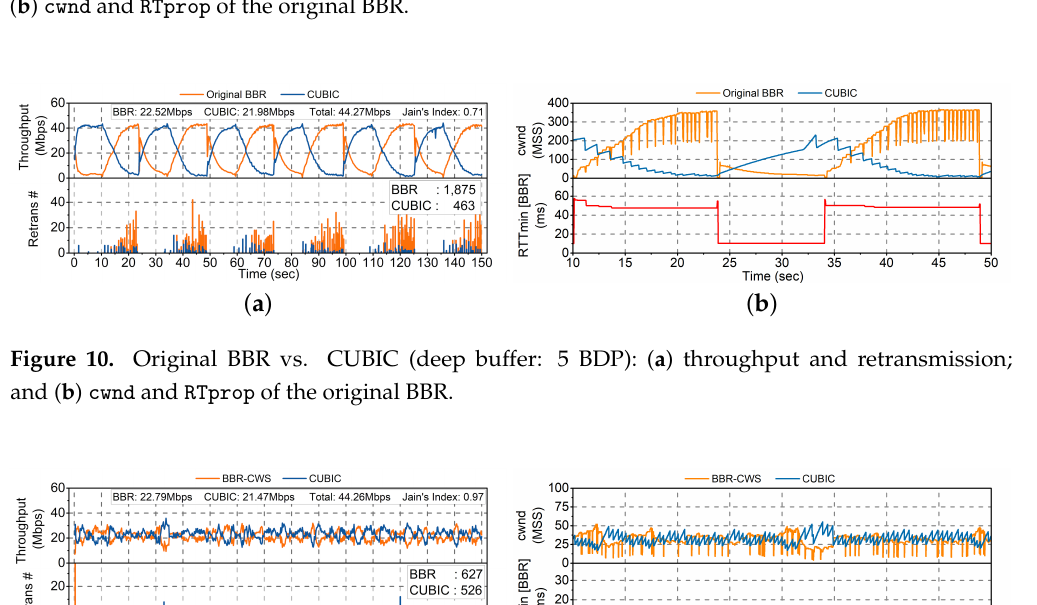
Figure 9. Original BBR vs. CUBIC (shallow buffer: 0.5 BDP): ( a ) throughput and retransmission; and ( b ) cwnd and RTprop of the original BBR.